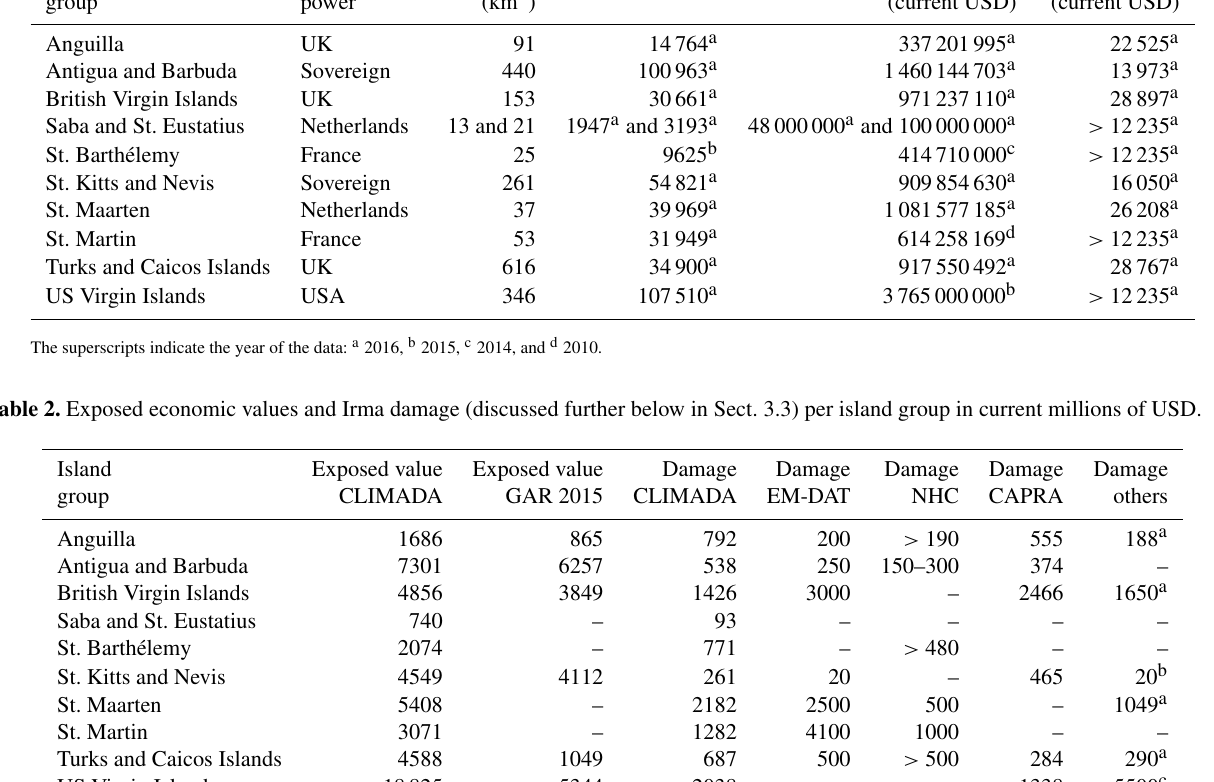
Table 1. Group of islands studied. Source is, in order prioritized, the World Bank, the UN data, the Central Bureau voor de Statistiek, and Comptes Economiques Rapides de l’Outre-mer and L’Institut d’Émission des Départements d’Outre-mer. The areas are obtained from Wikipedia.